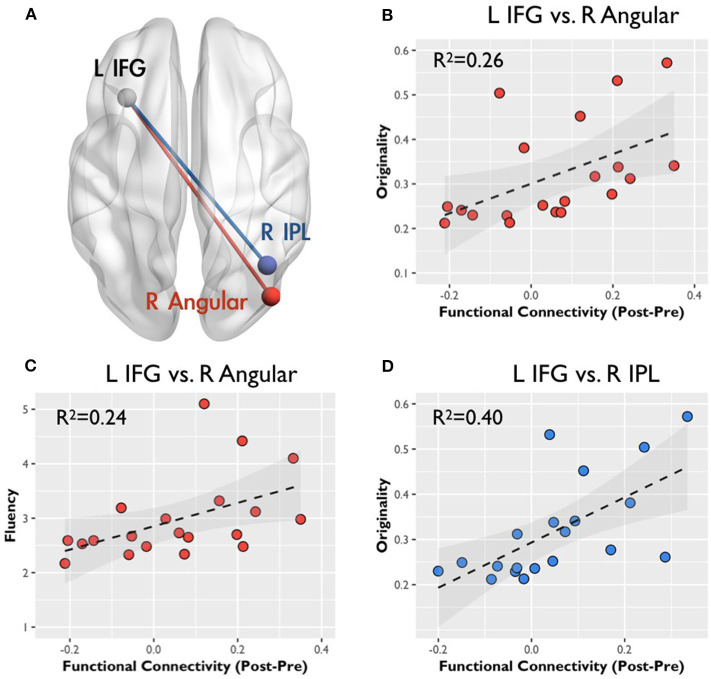
Correlation between the functional connectivity and creative behavior: color regions of two connectivity indicate spatial locations. (A) The gray spheres indicate the seeds for functional connectivity, the red line represents the connectivity between the left inferior frontal gyrus (IFG) and the right angular gyrus (AG), and the blue line indicates the connectivity between the left IFG and the right inferior parietal lobule (IPL). All scatter plots display the correlation between RSFC changes (in z-value) and CAQ, originality, and fluency scores in r squares. (B,C) Represent the relation with the connectivity change between the left IFG and the right AG, and (D) correspond to the relation with the connectivity change between the left IFG and the right IPL.